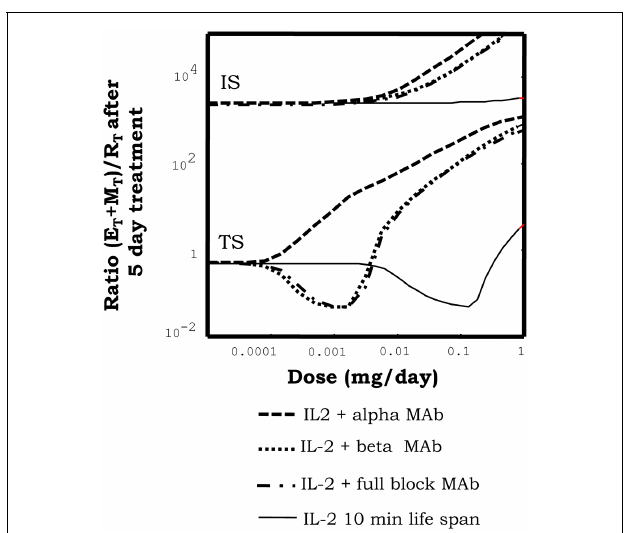
immune-complexes of IL2 plus antibodies anti-IL2, on the ratio of helper + memoryT cells versus regulatoryT cells [ratio (E + M)/R], in a system initialized either in tolerant (TS) or the autoimmune (IS) steady state . Different immune-complexes differ on the class of mAb used to form it (face alpha, face beta or fully blocking mAbs). immune-complexes are always formed with a 1:2 molar ratio of mAbs:IL2 and the dose applied is reported in terms of the mass of IL2 injected. If the simulations start with a system at theTS, immune-complexes formed with face beta or fully blocking mAbs reduce the ratio (E + M)/R for some intermediate dose values and then increases it for higher dose values.This is a pattern of response, qualitatively similar to that obtained with IL2 injection, but significantly displaced to the range of lower doses of IL2. If face alpha mAbs are used to form the complex the pattern of response obtained is qualitatively different.The ratio (E + M)/R always increase (favoring the expansion of E and M cells) and the larger the dose applied the larger the increment. If the simulations start with a system at the IS, all the possible immune-complexes behave qualitatively like the IL2 alone, they promote in dose-dependent way a further expansion of E and R cells, increasing the ratio (E +